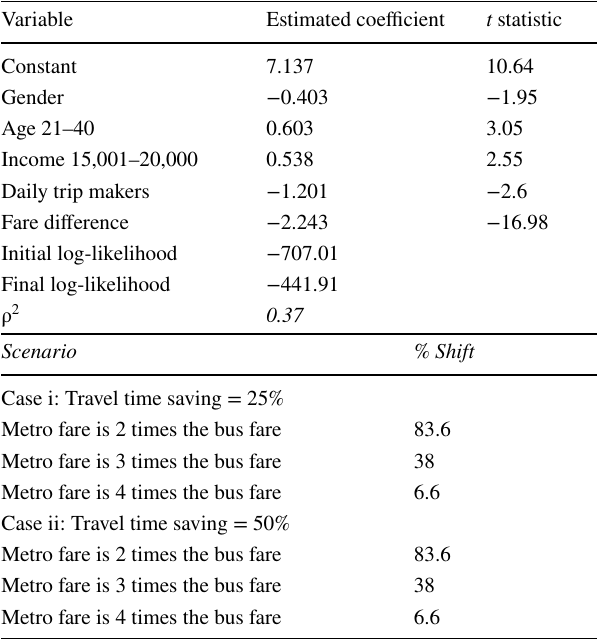
Table 10 Model development and probability of shift for work trip makers (using 1020 data